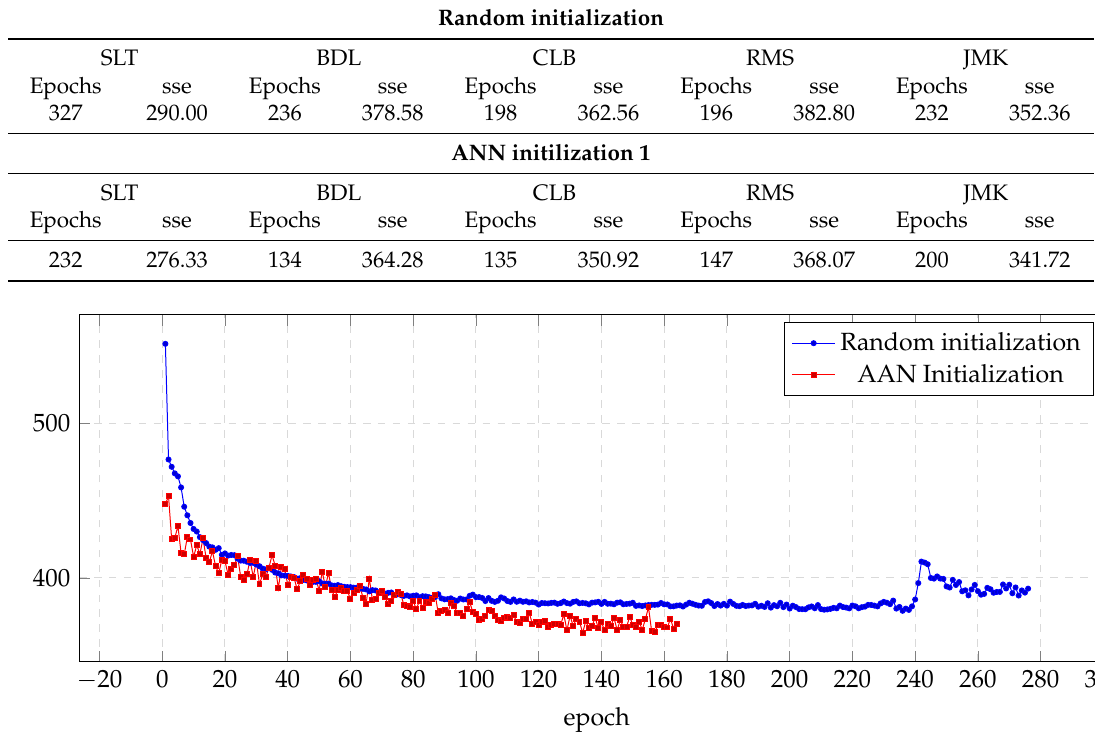
Table 2. Comparison of the results for the test set during training the Long Short-term Memory (LSTM) networks to enhance MFCC.